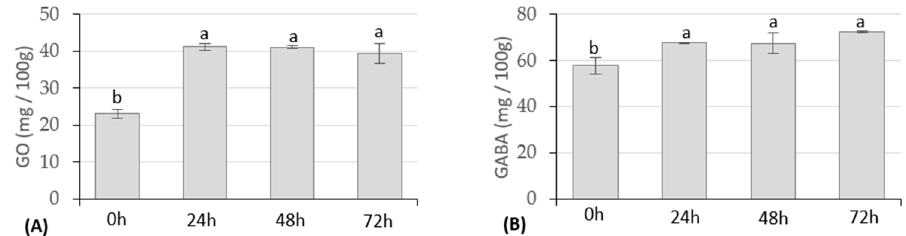
Figure 2. Effect of the germination time on the GO ( A ) and GABA ( B ) contents of brown Ariete variety rice, expressed in mg/100 g (DW). a, b—homogeneous groups according to Tukey’s post hoc test at a 95% con fi dence level.